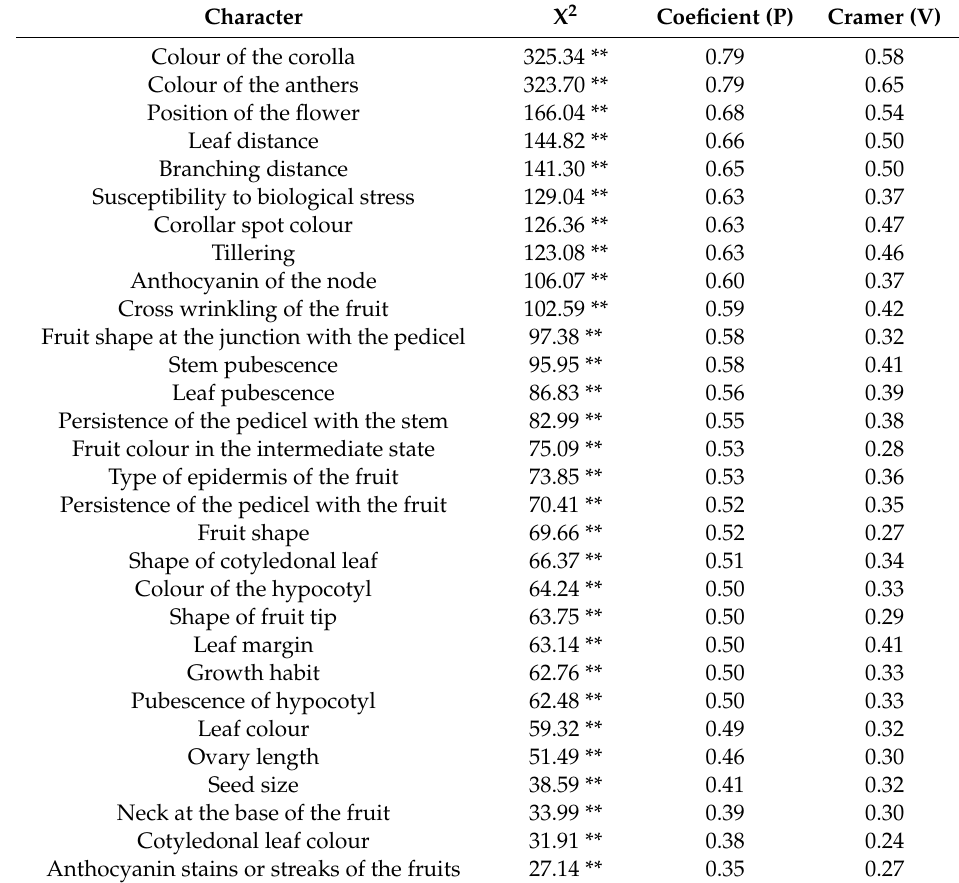
Table 5. Qualitative descriptors with the highest discriminant value influencing the genetic groups’ separation of Capsicum species.